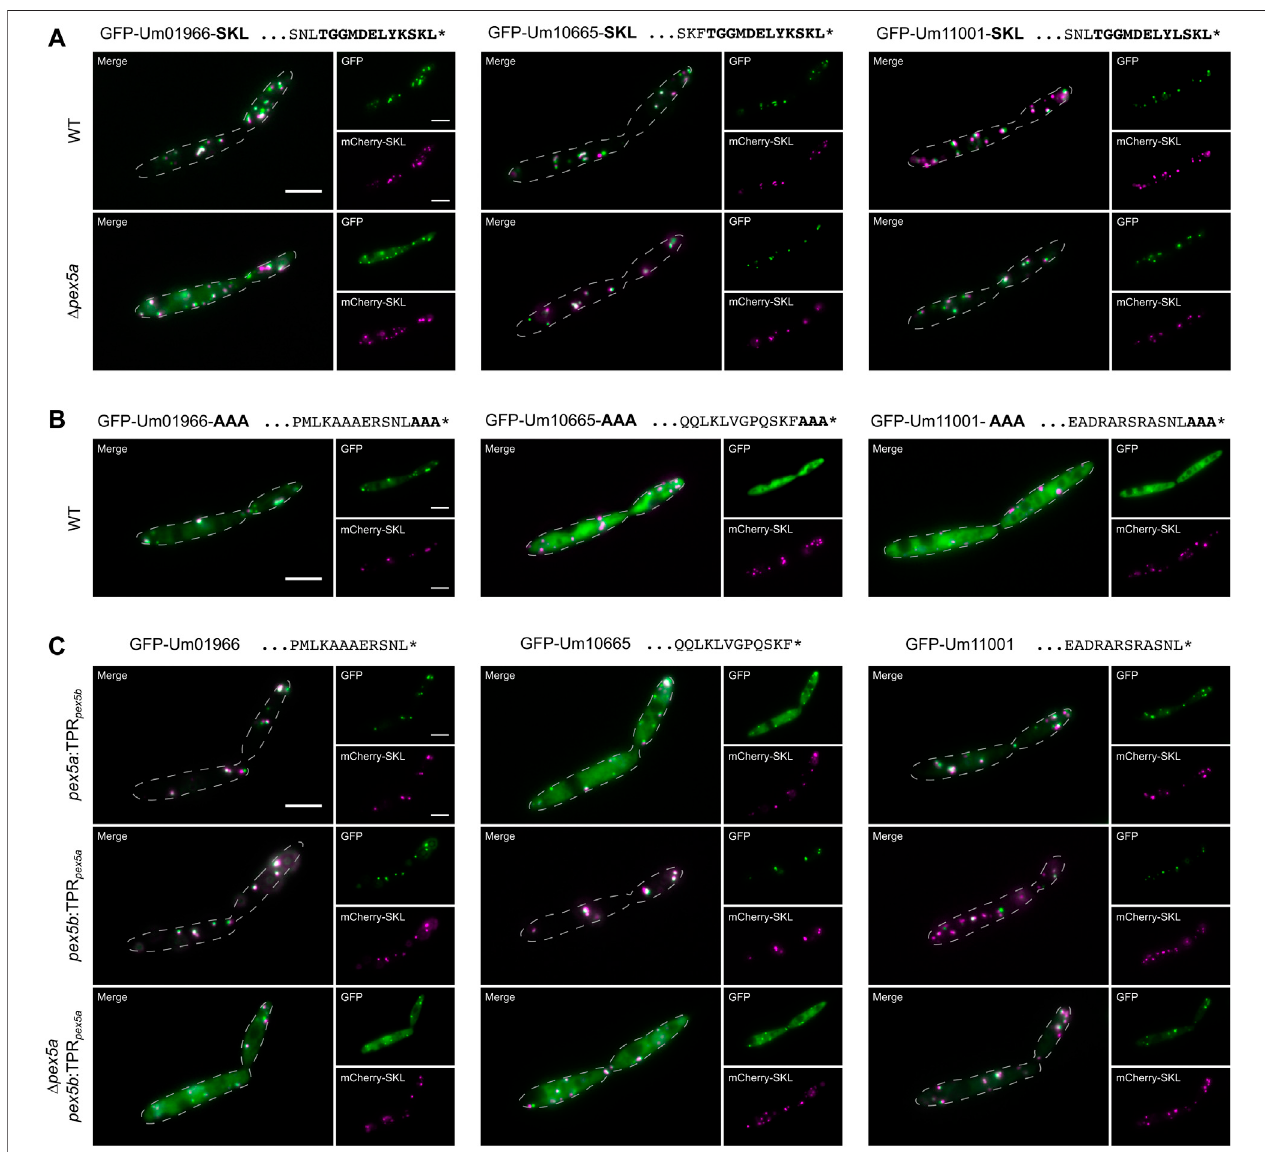
FIGURE 3 | The NTD of Pex5a acts as targeting factor for Um01966. Fluorescence microscopic images of indicated strains expressing the peroxisomal marker protein mCherry-SKL (magenta) together with GFP-tagged full-length proteins (green) with their usual PTS1maskedby SKL (A) or AAA (B) in Δ pex5a and Δ pex5b cells. (C) Representative images of GFP-tagged full-length proteins expressed in mutants containing chimeric receptor proteins. These data reveal that both the NTD and the CTD contribute to cargo import.